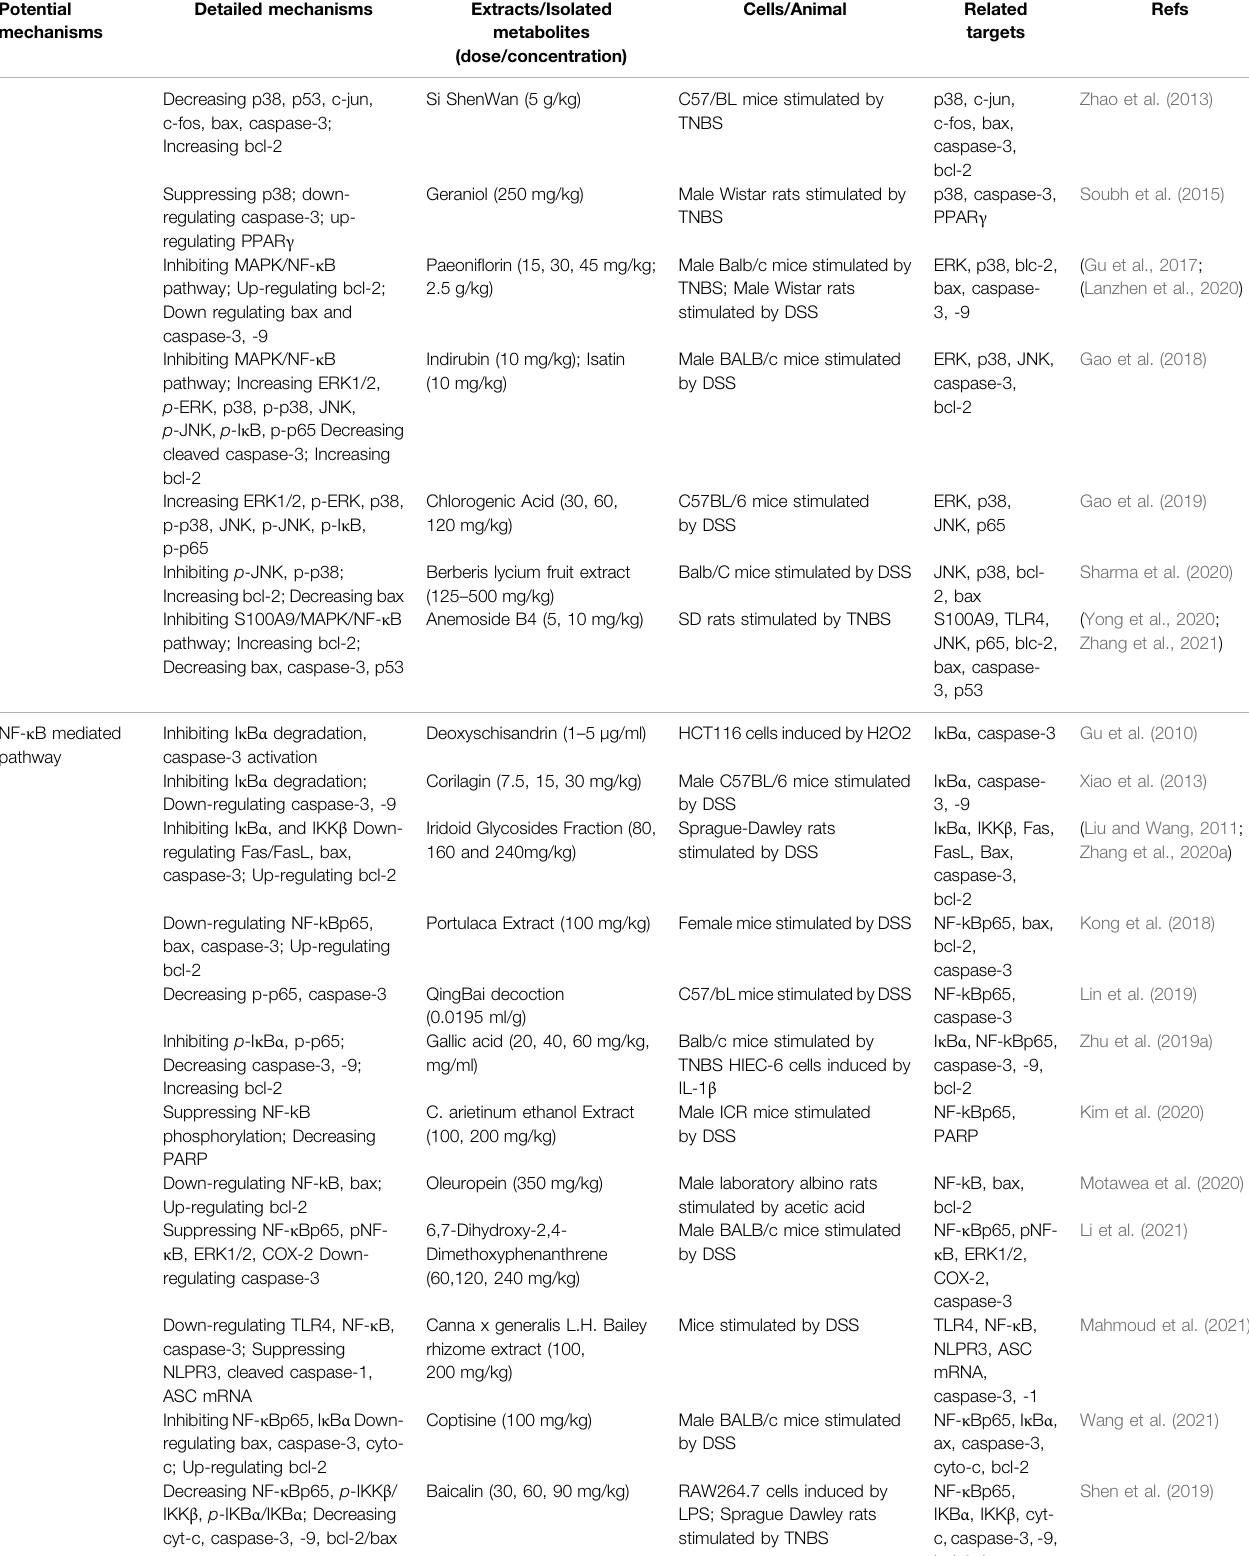
TABLE 1 | ( Continued ) Anti-apoptotic activities of natural products on UC-induced intestinal epithelial